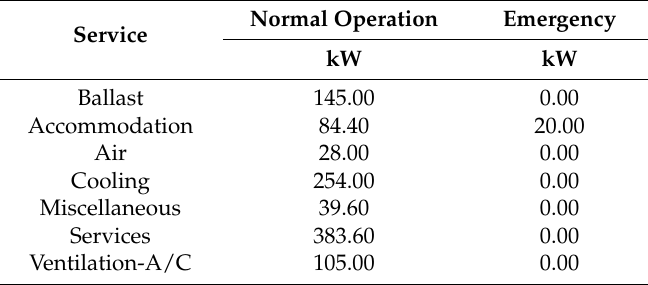
Table 5. Average power consumption of an off-shore